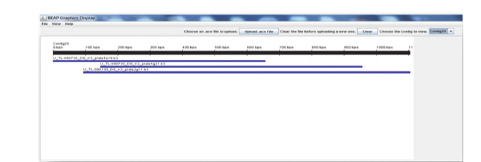
Figure 7: The result of Contig 20 that was obtained by CAP3 with